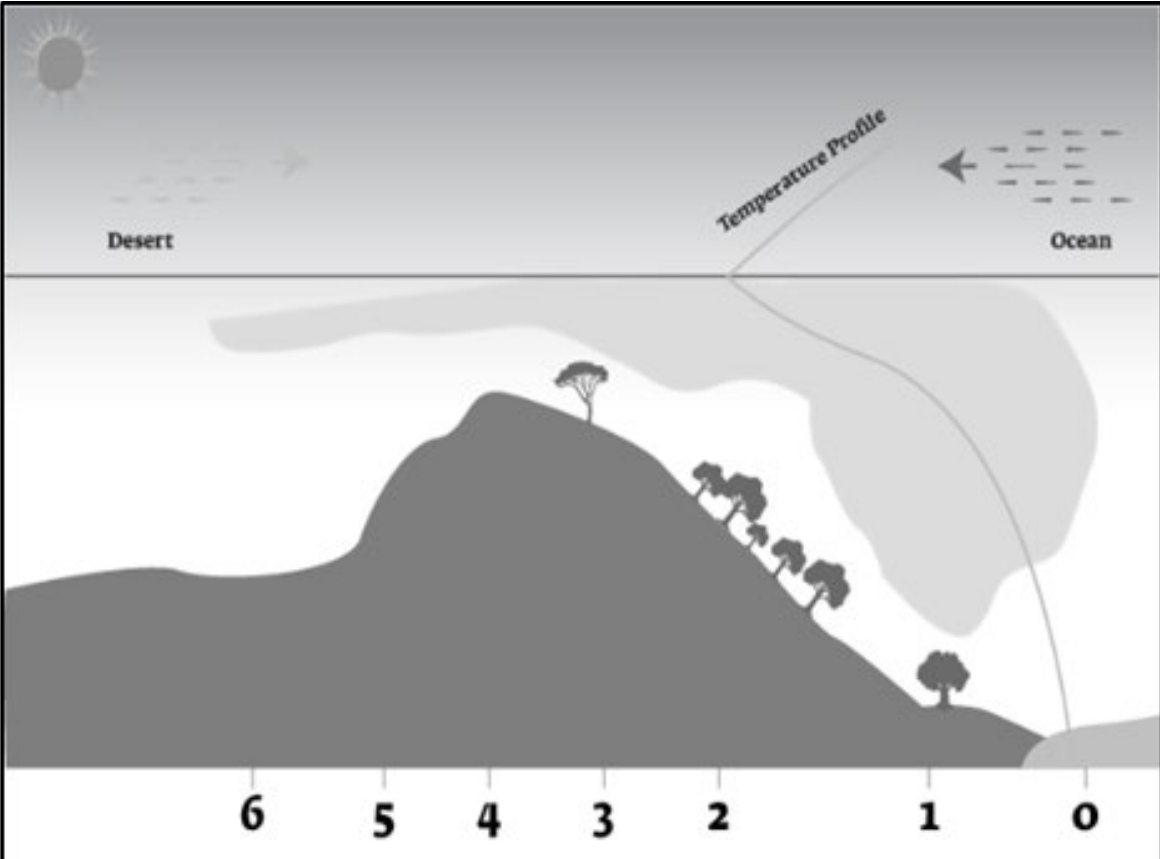
Figure 13. Climate conditions in Dhofar during the monsoon, and a diagrammatic representation of a section revealing the main habitats from sea to desert: 0—ocean; 1—coastal; 2—foothills; 3—escarpment; 4—dry plateau; 5—northern cliffs; 6—desert (modified source from source: Hildebrandt et al., 2007).